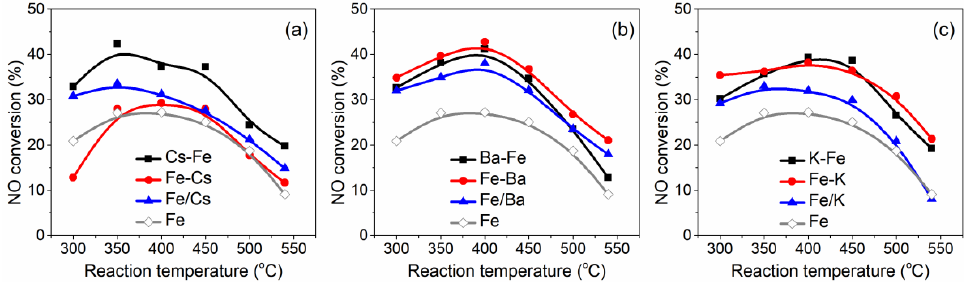
Figure 3. NO conversion of metal-doped Fe-HZSM-5: ( a ) Cs promoter; ( b ) Ba promoter; ( c ) K promoter. NO = 1000 ppm, SO 2 = 500 ppm, O 2 = 10 vol.% with N 2 as balance gas, GHSV = 15,000 h − 1 .